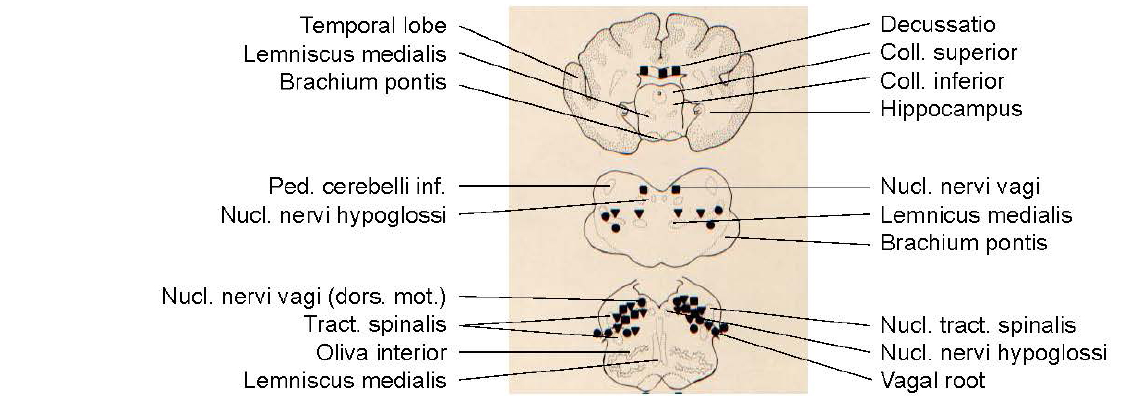
Figure 4. Distribution of herpetic lesions in the brains of newborn baboons following intratracheal SA8 infections.